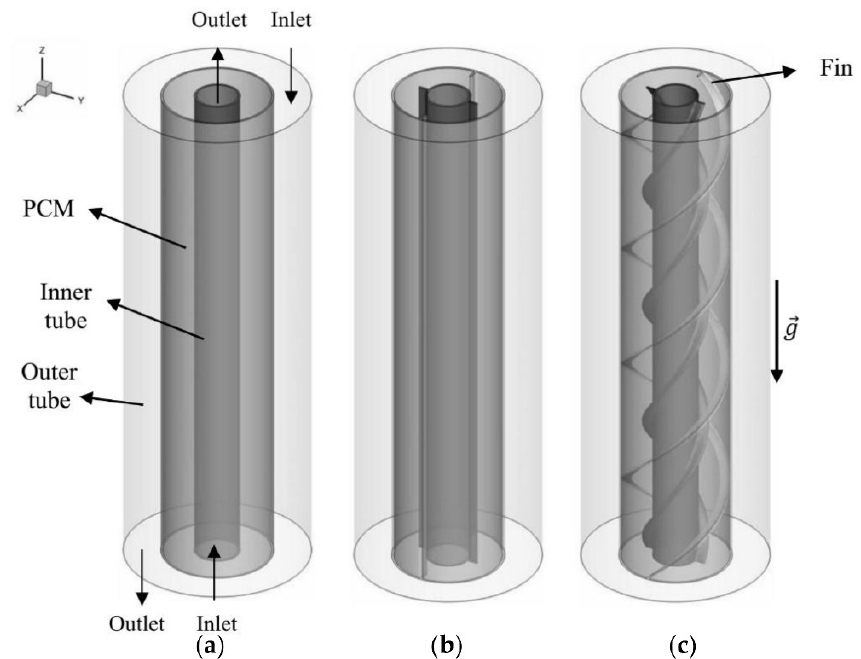
Figure 1. The schematic of the proposed double-tube heat exchanger with twisted fins using: ( a ) no fins, ( b ) straight fins, and ( c ) twisted fins.